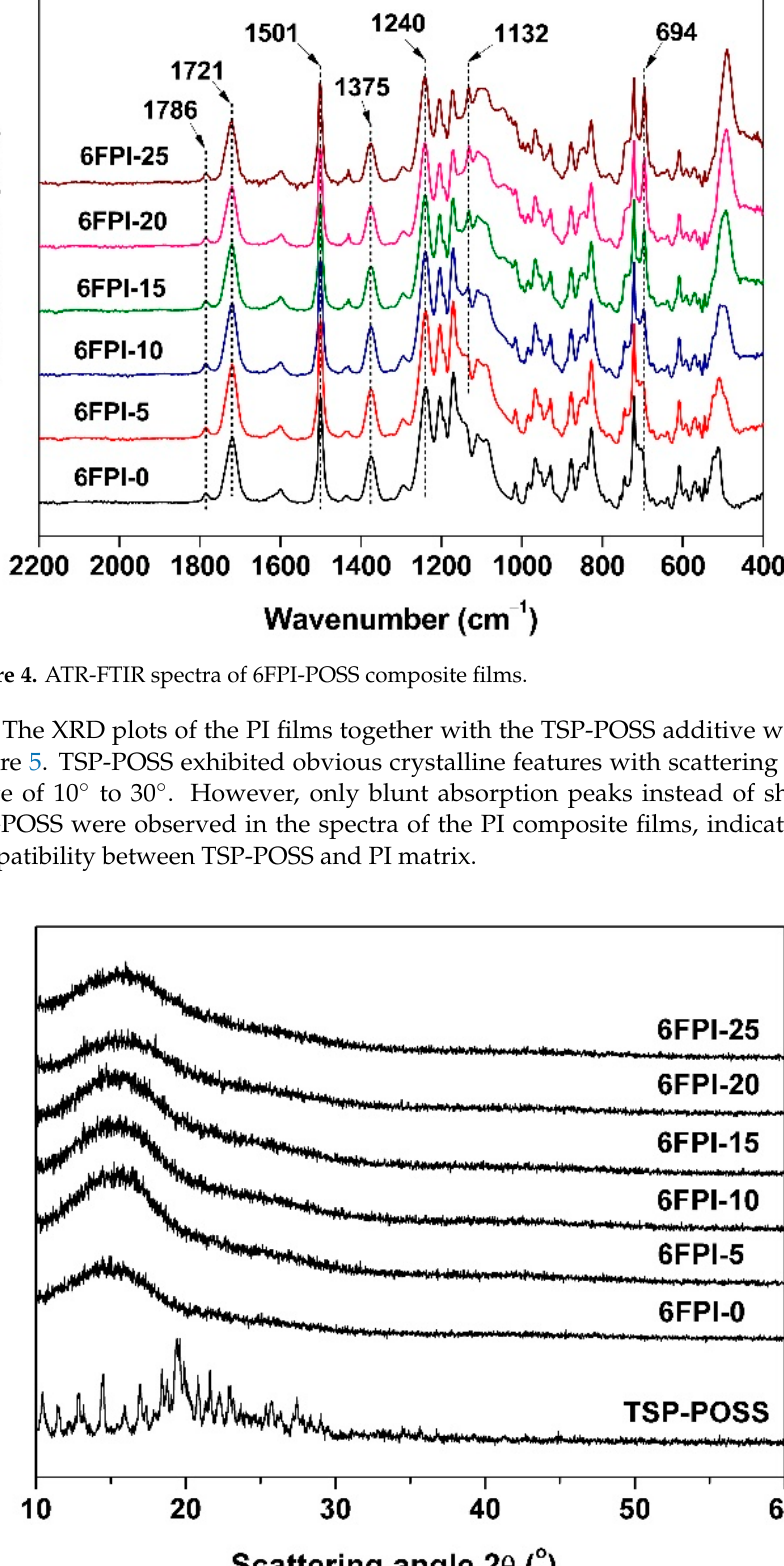
Figure 5. XRD plots of 6FPI-POSS composite films.